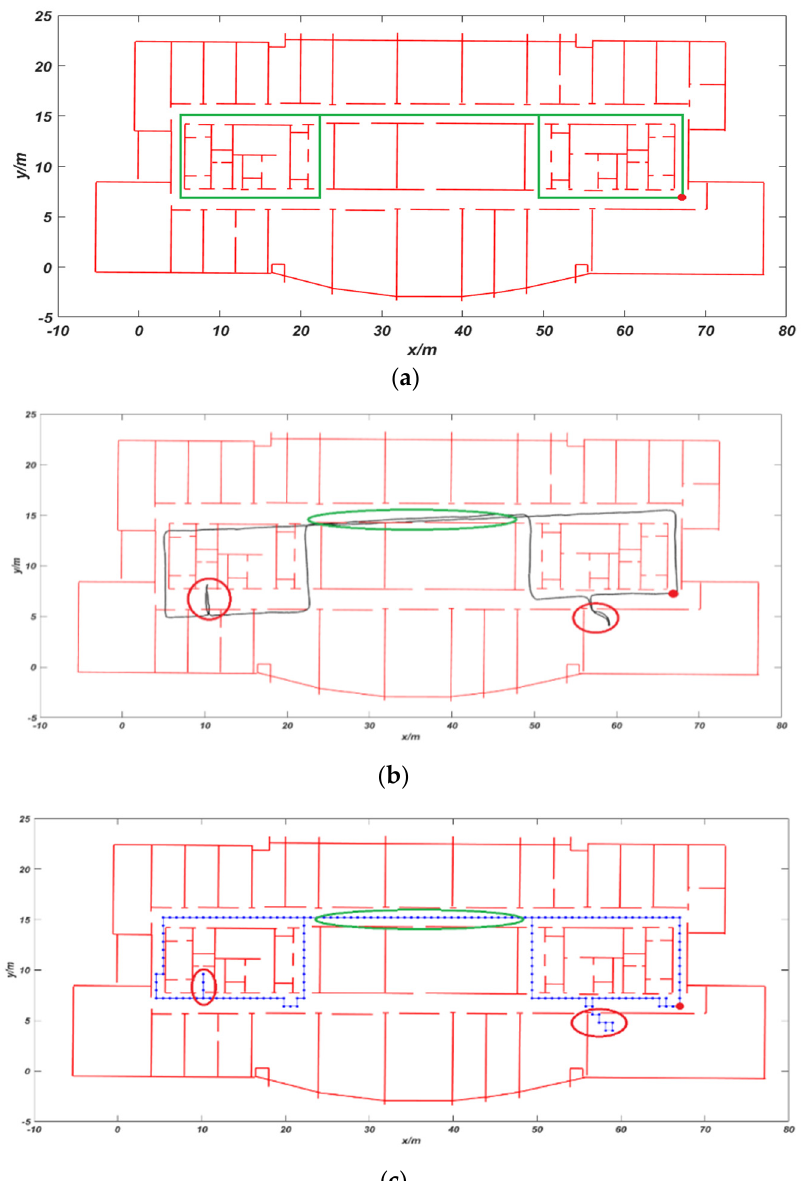
Figure 7. Comparison of trajectory: ( a ) preset trajectory; ( b ) VIO trajectory; and ( c ) trajectory using the conditional random field (CRF) algorithm.